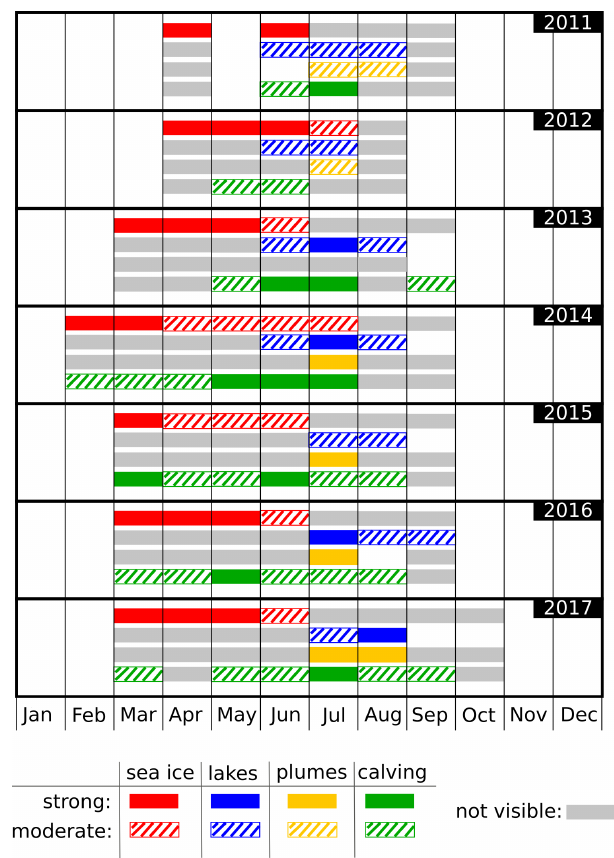
Figure 11. Occurrence of four different visual features from 2011 to 2017. Examples for the assessment of these visual features in Landsat scenes are given in Appendix E.